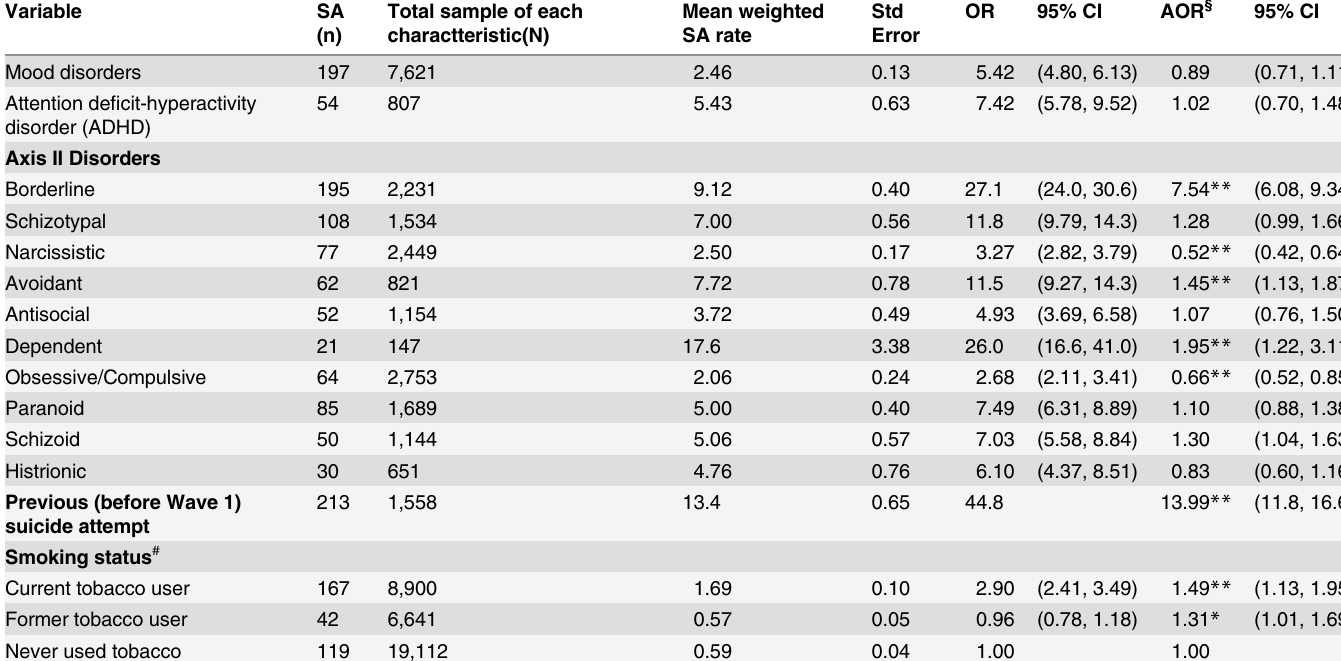
and recent (r = 0.373) suicide attempts and with other study covariates in polychloric correla- tional analyses (data not